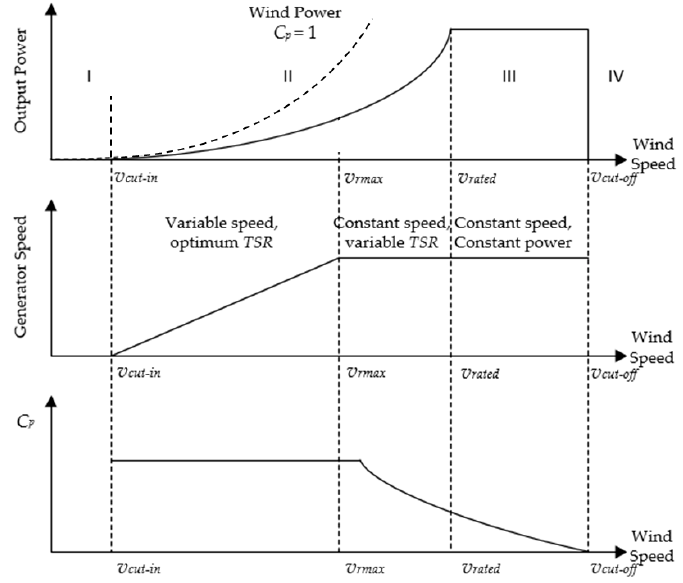
Figure 1. Different regions of wind turbine operation with wind speed.